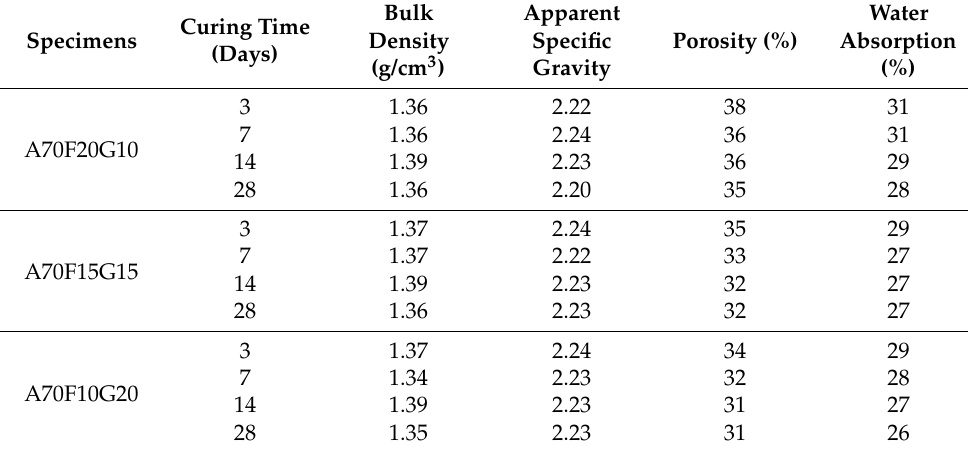
Table 9. The physical properties of AFG geopolymers.